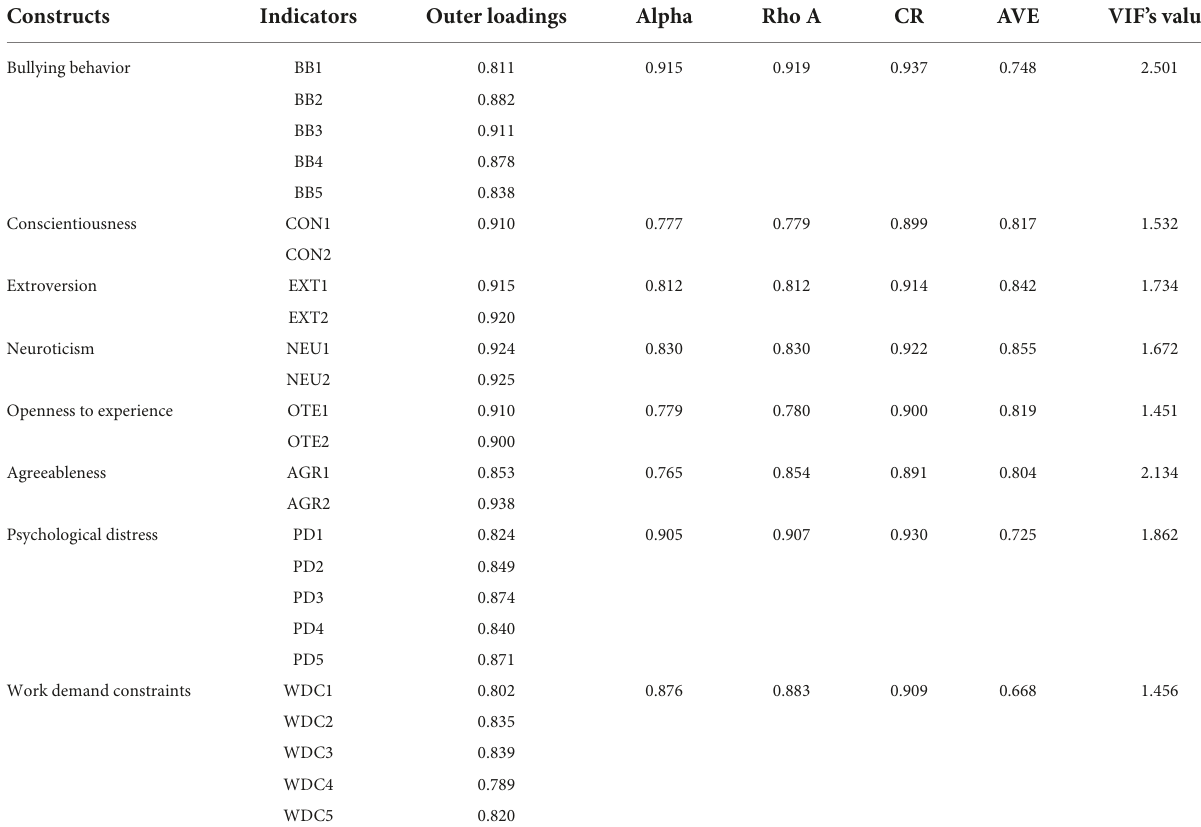
TABLE 2 Factor loadings of variables [per item, Cronbach alpha, composite reliability, and average variance extracted (AVE)].